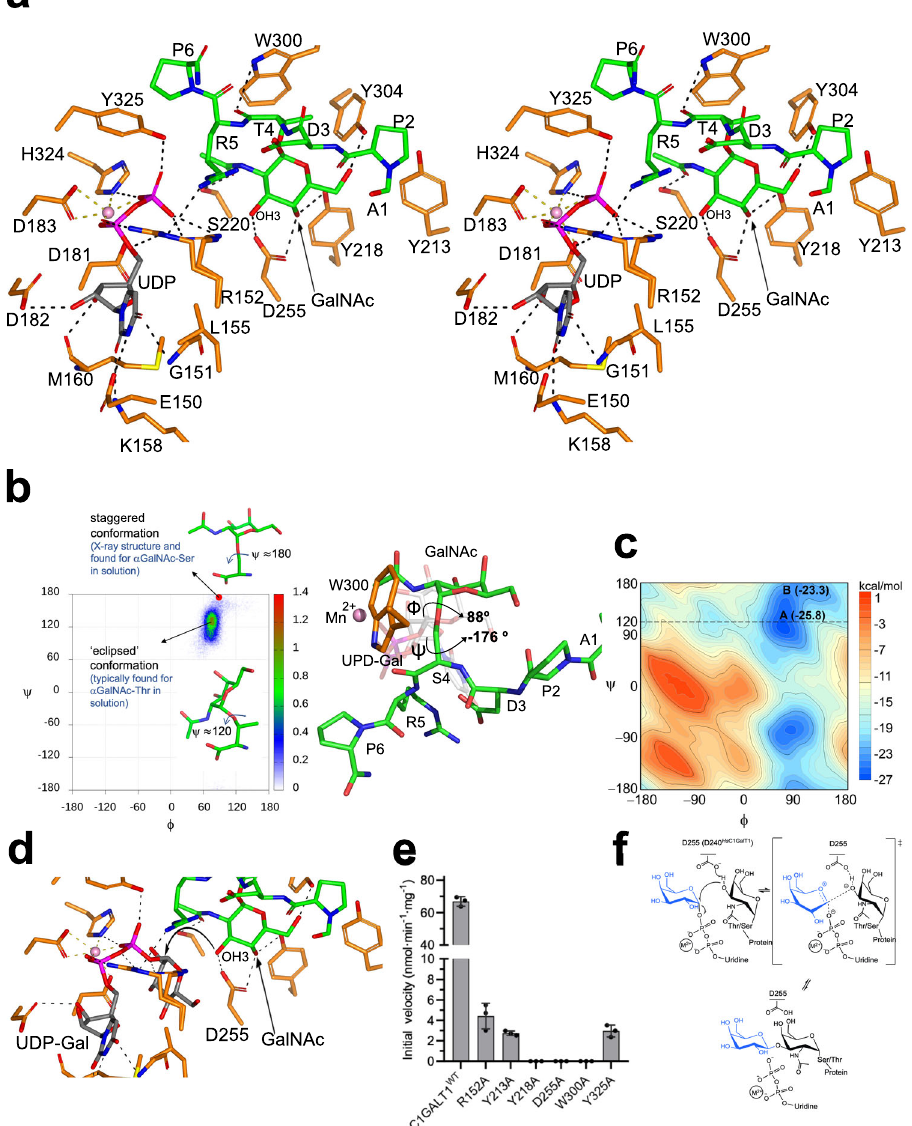
Fig. 4 Structural features of the active site. a Stereo view of the active site for the Dm C1GalT1-UDP-Mn 2 + -APDT*RP complex. The residues forming the active site are depicted as orange carbon atoms. UDP and the glycopeptide are shown as gray and green carbon atoms, respectively. The manganese atom is shown as a pink sphere. Hydrogen bond interactions are shown as dotted black lines. b Geometry of the glycosidic linkage of the glycopeptide APDT*RP in solution derived from 0.5 µ s MD simulations. The dihedral angles are de fi ned as follow, ϕ = O5-C1-O1-C β , and ψ = C1-O1-C β -C α . The red circle corresponds to the conformation found for this linkage in the crystal structure of the glycopeptide bound to Dm C1GalT1 in the presence of UDP. This conformation is also present in glycopeptide APDS*RP in solution (left panel). 3D view of APDS*RP in complex with Dm C1GalT1 in the presence of UDP-Gal obtained from 0.5 µ s MD simulations (rigth panel). c Free-energy map ( ϕ , ψ ) of the glycosidic dihedral angle calculated for the free peptide APDT*RP in water (see Methods ) at 300 K. The contour maps are drawn with a spacing of 1 kcal/mol. Regions that were never visited by the peptide are shown in dark orange. “ A ” refers to the ‘ eclipsed ’ conformation typically found for α -GalNAc-Thr derivatives in solutions 47,50 . “ B ” refers to the ‘ staggered ’ conformation found for α -GalNAc-Ser derivatives in solution 72 . d Close-up view of the binding site region of the Dm C1GalT1-UDP-Gal-APDT*RP complex showing the Asp255 as the catalytic base in the plausible S N 2 single-displacement reaction mechanism. Note the proximity and the orientation of the GalNAc OH3 to the anomeric carbon (3.81 Å) which is compatible with the inversion of the con fi guration during the reaction. e Histogram showing the relative activities of the mutants compared to the wild-type (WT) protein. All experiments were done in triplicate ( n = 3 independent experiments). Error bars represent the standard deviation calculated by the GraphPad Prism fi t of the data sets. Source data are provided as a Source Data fi le. f Proposed S N 2 single- displacement reaction mechanism for